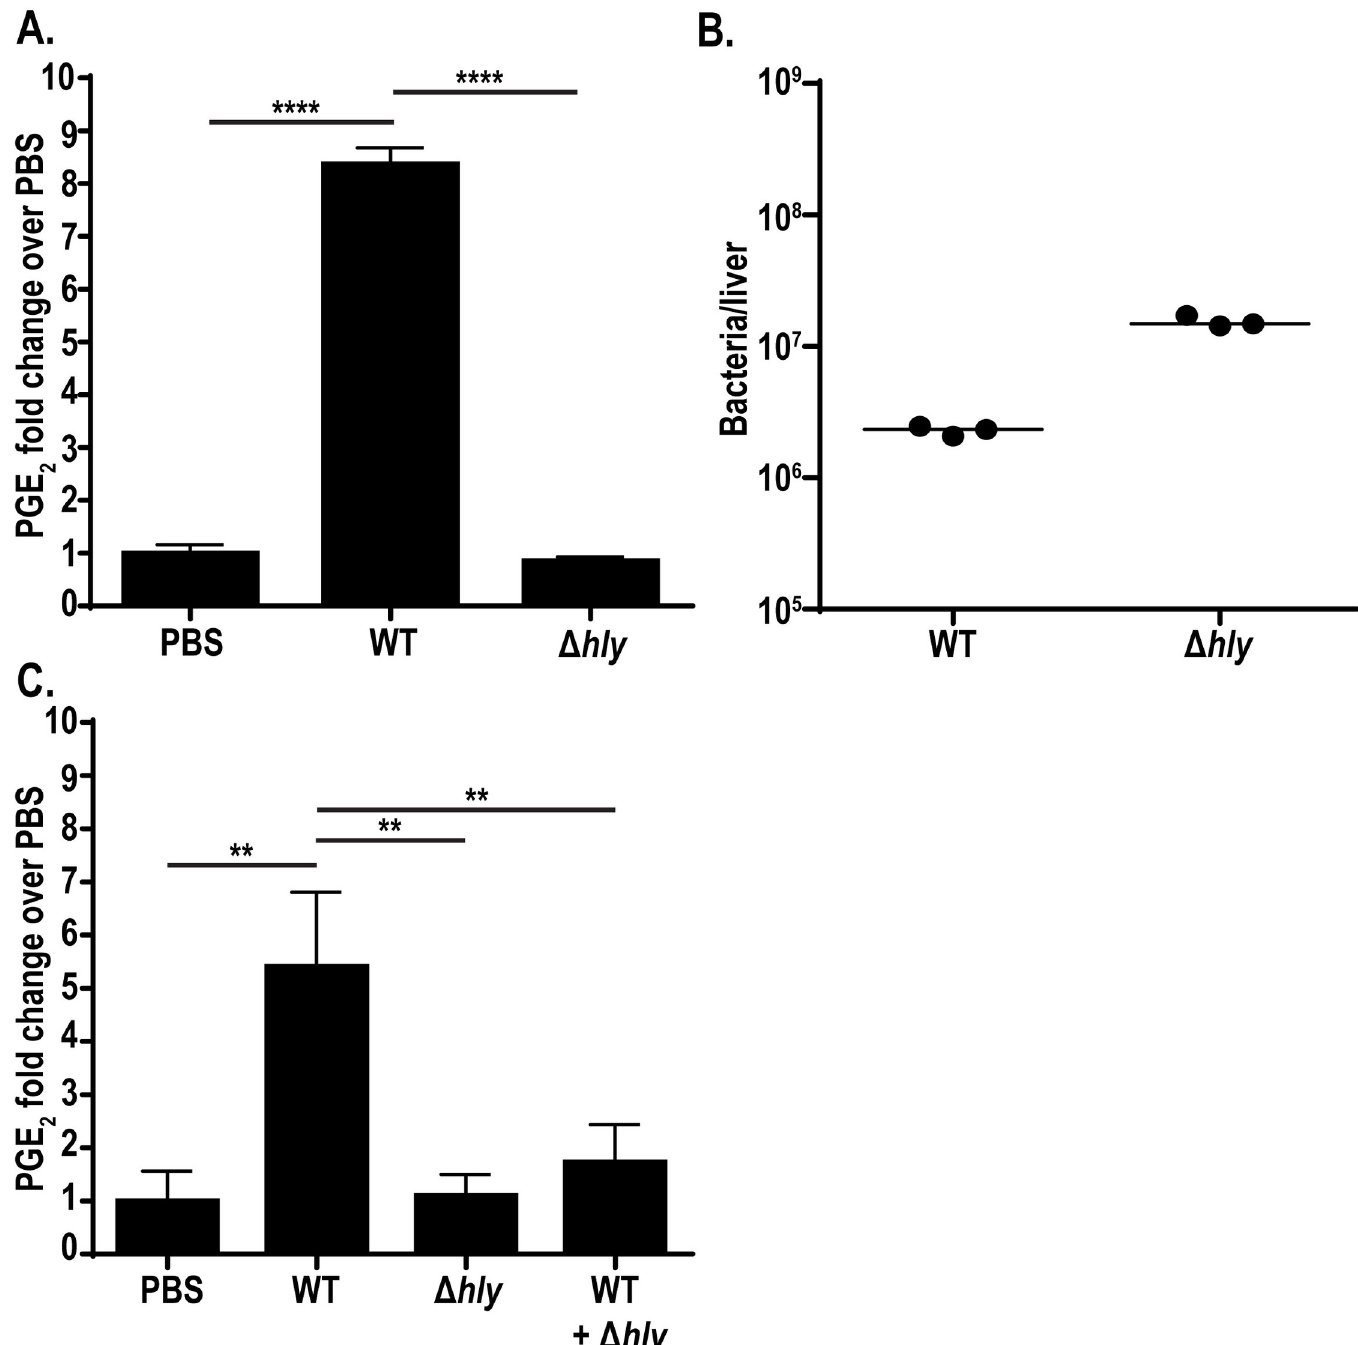
Fig 2. Cytosolic access is necessary for L . monocytogenes -stimulated PGE 2 production in vivo . C57BL/6 mice were infected with 10 5 wild-type or 10 7 Δ hly L . monocytogenes . 12hpi spleens were harvested for eicosanoid extraction and mass spectrometry (A) and livers were harvested for bacterial burdens (B). C57BL/6 mice were infected with 10 5 wild-type, 10 7 Δ hly L . monocytogenes , or a combination of both strains. 12hpi spleens were harvested for eicosanoid extraction and mass spectrometry (C). Data are representative of two independent experiments. Mass spectrometry data was normalized to d-PGE 2 levels and fold change is compared to PBS controls. Significance was determined by a one-way ANOVA with Bonferroni’s correction. �� p < 0.01, ���� p < 0.0001.